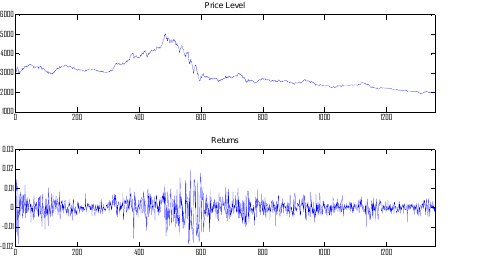
Fig. 1.b Series of Saudi stock market price level and returns